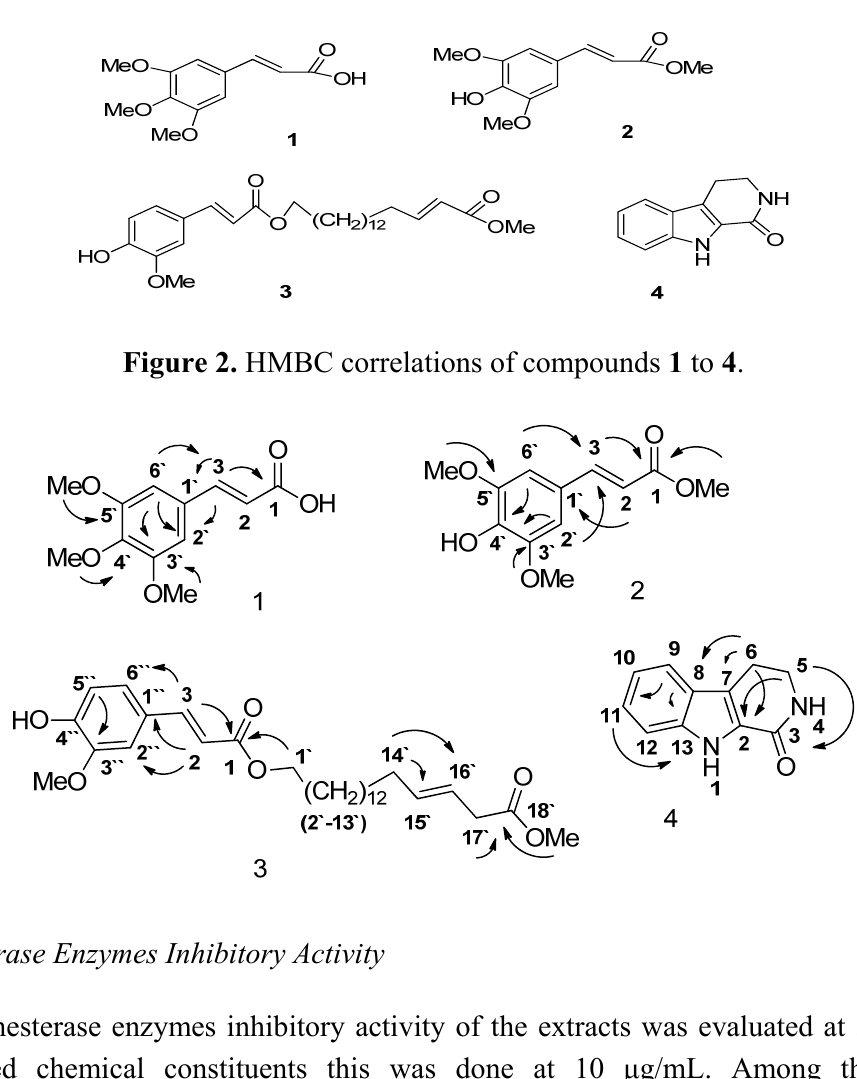
Figure 1. Compounds isolated from leaves of R. reflexa .